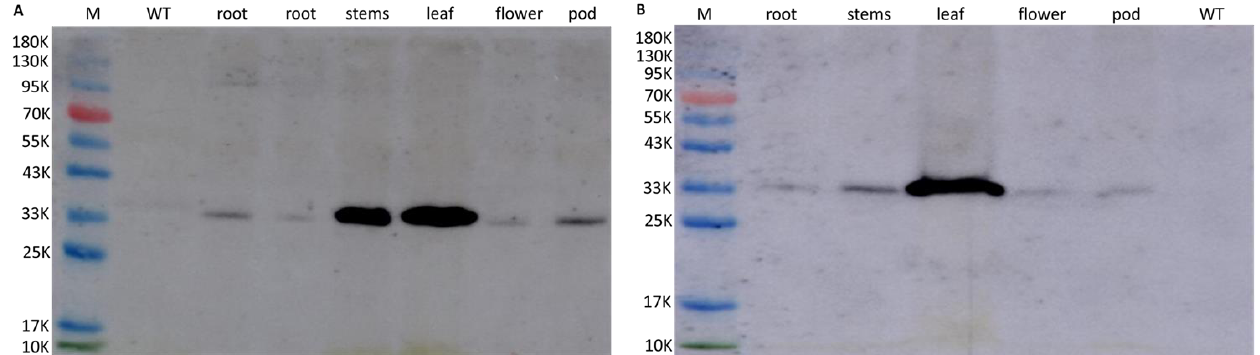
Figure 5. Western blotting analysis of the expression of BAR protein from the different tissues in T 4 plants 3-1 ( A ) and 31-1 ( B ). Lane M is ladder marker; lane WT is leaf of wild-type soybean.